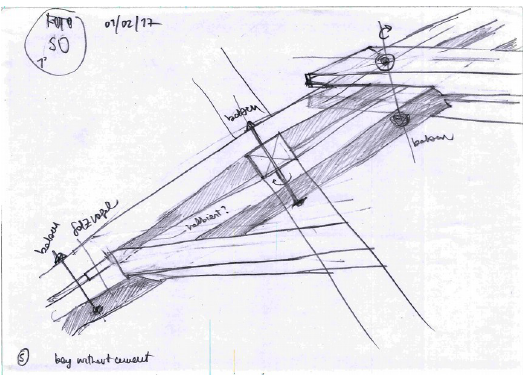
Figure 12. Measured survey on a detail of the pagoda with observation on the connection’s methods and